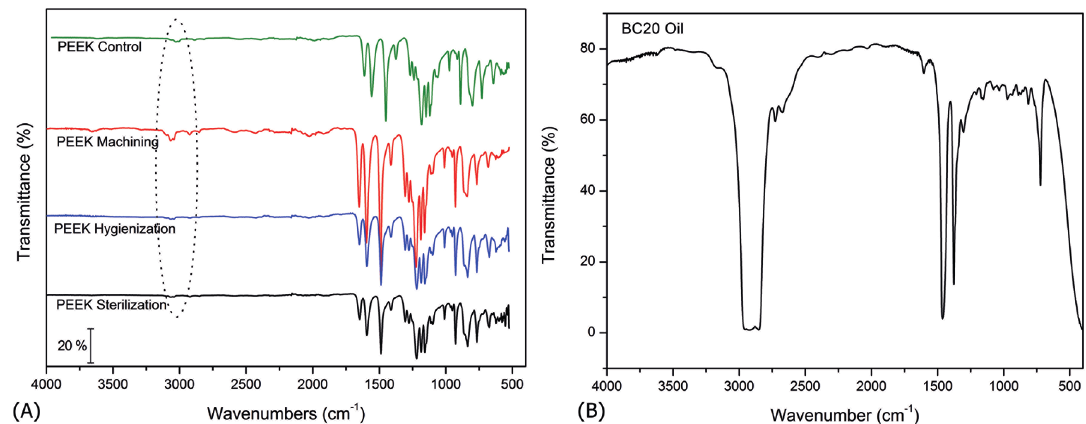
Figure 3: FTIR of PEEKc samples (A) before and after machining, hygienization and sterilization process stages and (B) BC20 machining oil by ATR.